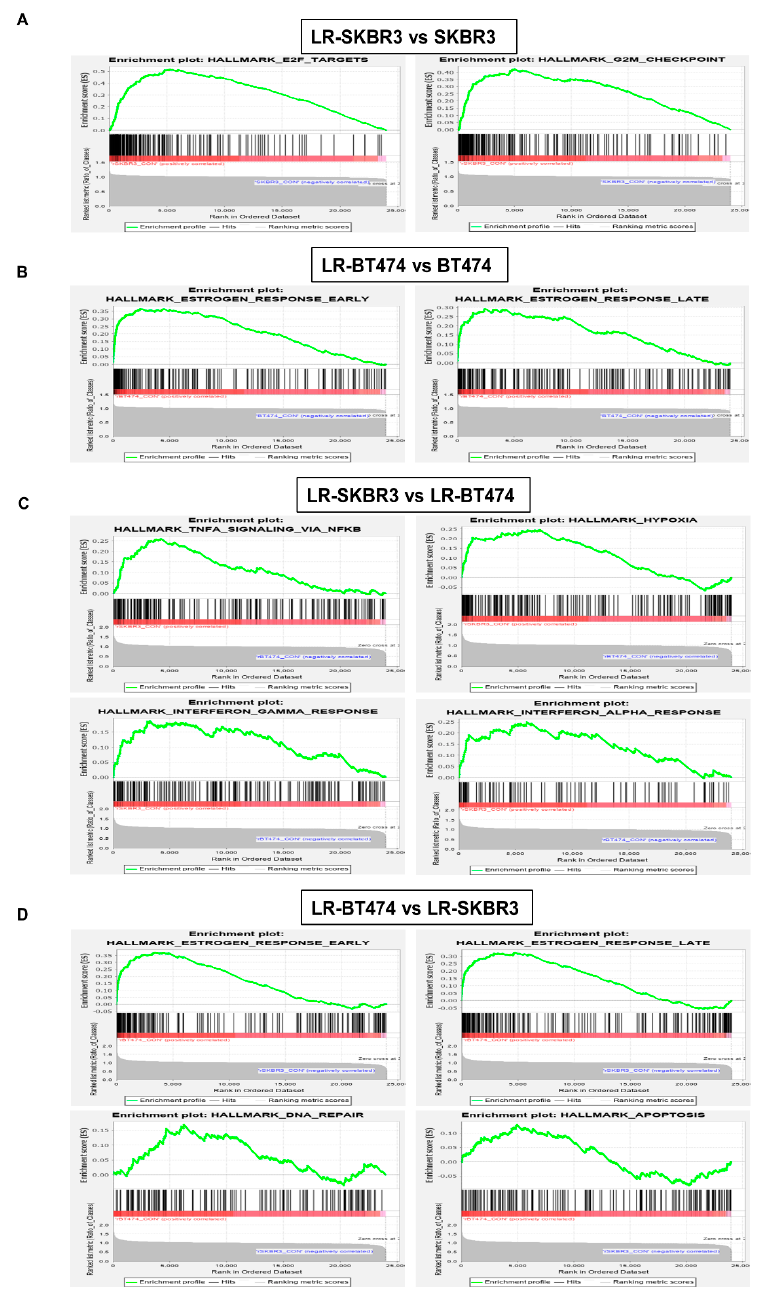
Figure 2. Gene set enrichment analysis (GSEA) enrichment plot in lapatinib-resistant cell lines. ( A ) GSEA plot shows G2M checkpoint and E2F target in LR-SKBR3 and SKBR3 cells. ( B ) GSEA plot shows early and late estrogen responses in LR-BT474 and BT474 cells. ( C ) GSEA analysis represents gene expression enrichment in LR-SKBR3 cell compared with LR-BT474 cell. ( D ) GSEA analysis represents gene expression enrichment in LR-BT474 cell compared with LR-SKBR3